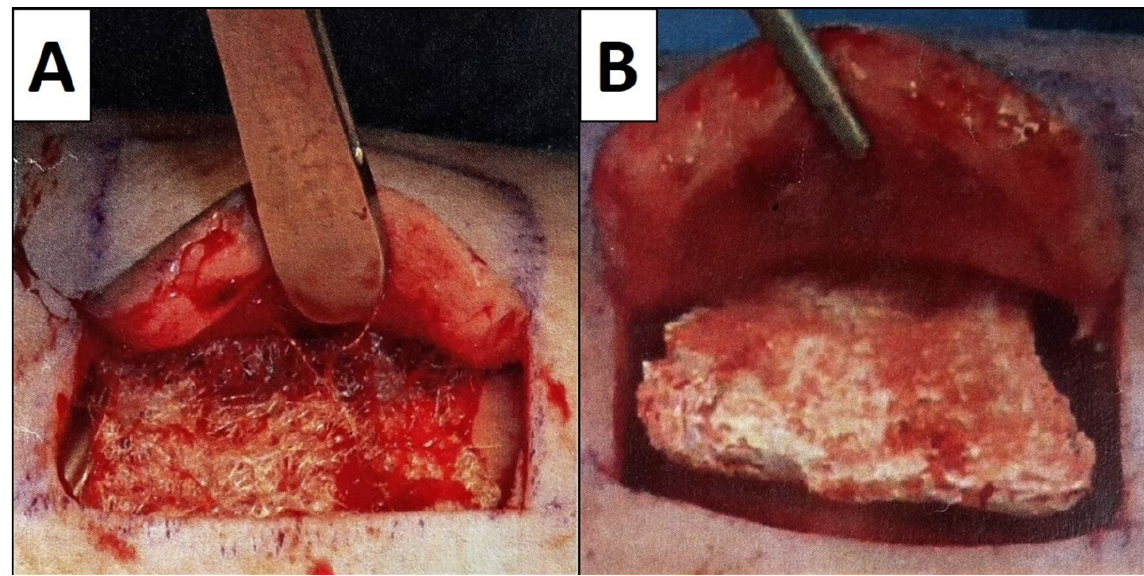
Figure 2. Examples for the subcutaneous implantation procedure of the biomaterial scaffolds. ( A ) Implantation of a filamentous fleece in a skin pocket. ( B ) Implantation of a sponge-like scaffold in a skin pocket.